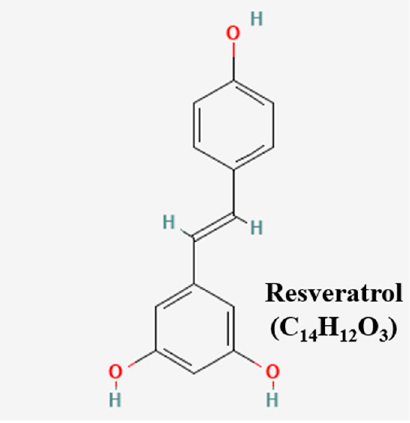
Figure 7. Chemical structure of compound reversing drug resistance.